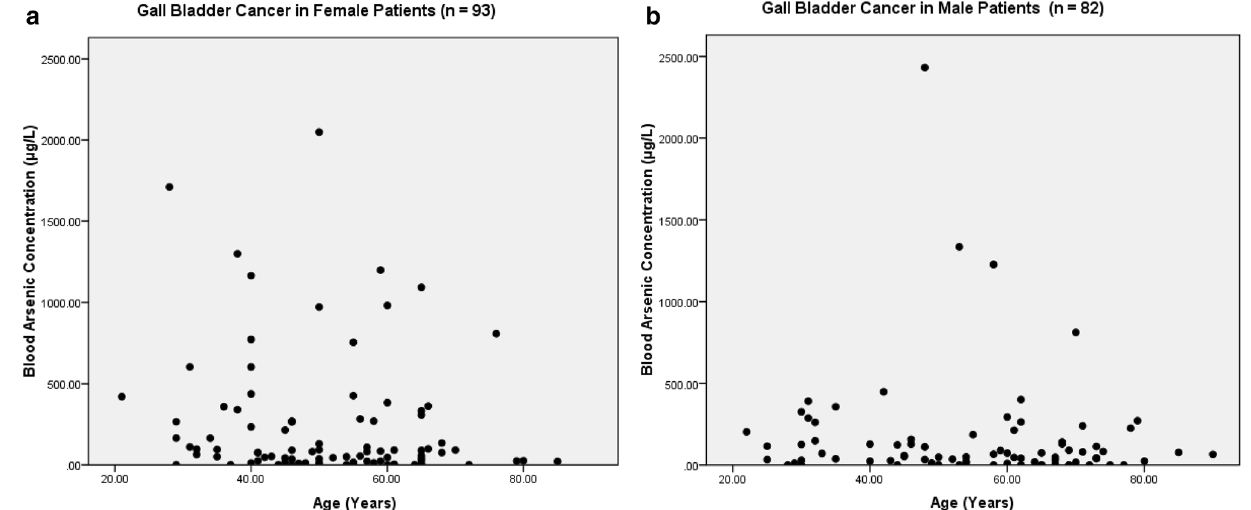
Figure 10. The correlation coefficient between blood arsenic levels and age of the female vs male gallbladder cancer patients (P < 0.05).